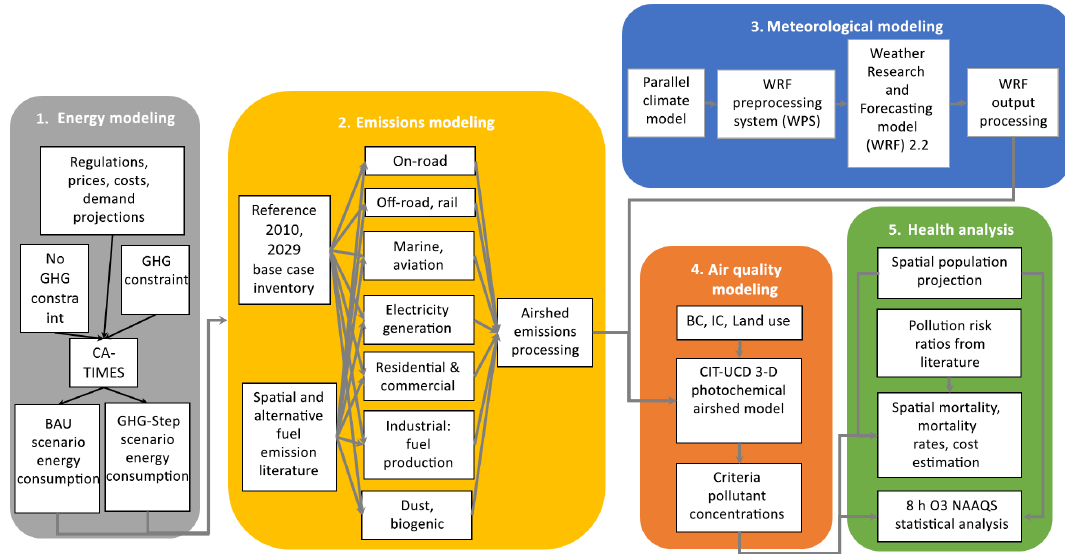
Figure 1. Process diagram of sequence of stages for modeling and